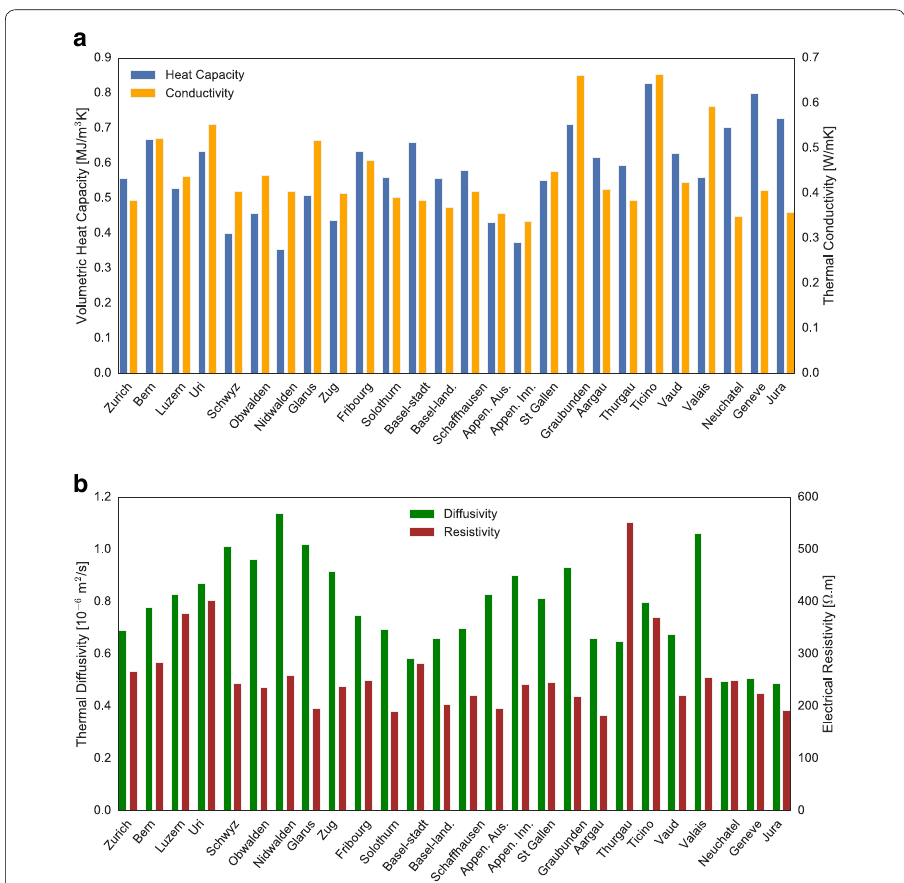
Fig. 21 Estimated variables aggregated at canton level. a Volumetric Heat Capacity and Thermal Conductivity aggregated at canton level, b Thermal Diffusivity and Electrical Resistivity aggregated at canton